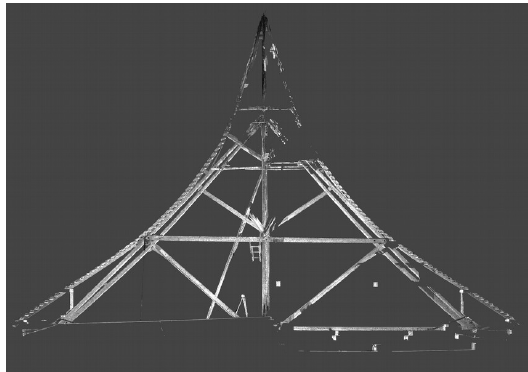
Figure 6. Transversal section of the pagoda. The main structural elements are extrapolated thanks to the box